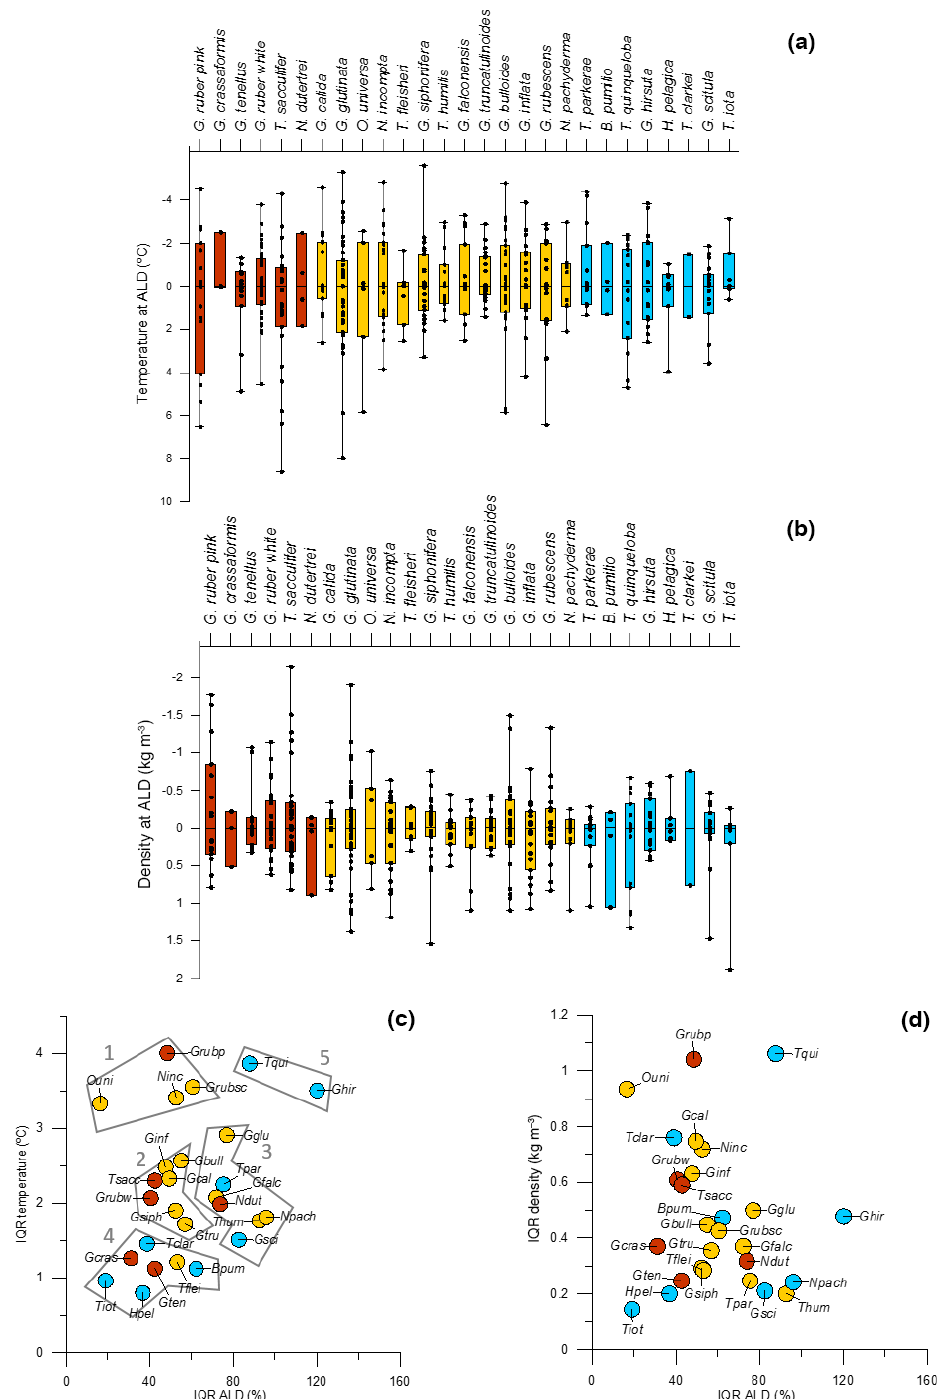
Figure 10. (a) Average temperature ( ◦ C) at ALD and (b) average seawater density (kgm − 3 ) at ALD for the 27 most abundant species normalized to the median value for each species and (c) relationship between the interquartile range of temperature ( ◦ C) at ALD (kgm − 3 ) and interquartile range of ALD expressed as percentage of mean ALD for each species, whereas the group numbers stand for 1 – species showing a large spread in temperature at the ALD (average living depth) but a small relative ALD range; 2 – species showing an intermediate spread in T ALD and narrow relative ALD range; 3 – species with intermediate T ALD range and variable relative ALD; 4 – species with narrow T ALD and narrow relative ALD; 5 – species with variable T ALD and variable ALD and (d) the same for seawater density at ALD. The species are ordered by their mean ALD mean and colored according to their habitat depth preferences (Fig. 7). Dots represent individual observations. Only species with sufficient number of observations are